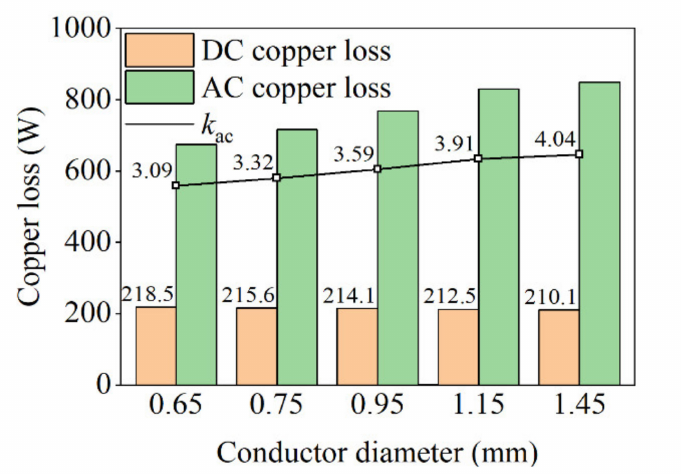
Figure 11. Copper loss and AC/DC copper loss ratio k ac with conductor diameter at 1000 Hz for Case